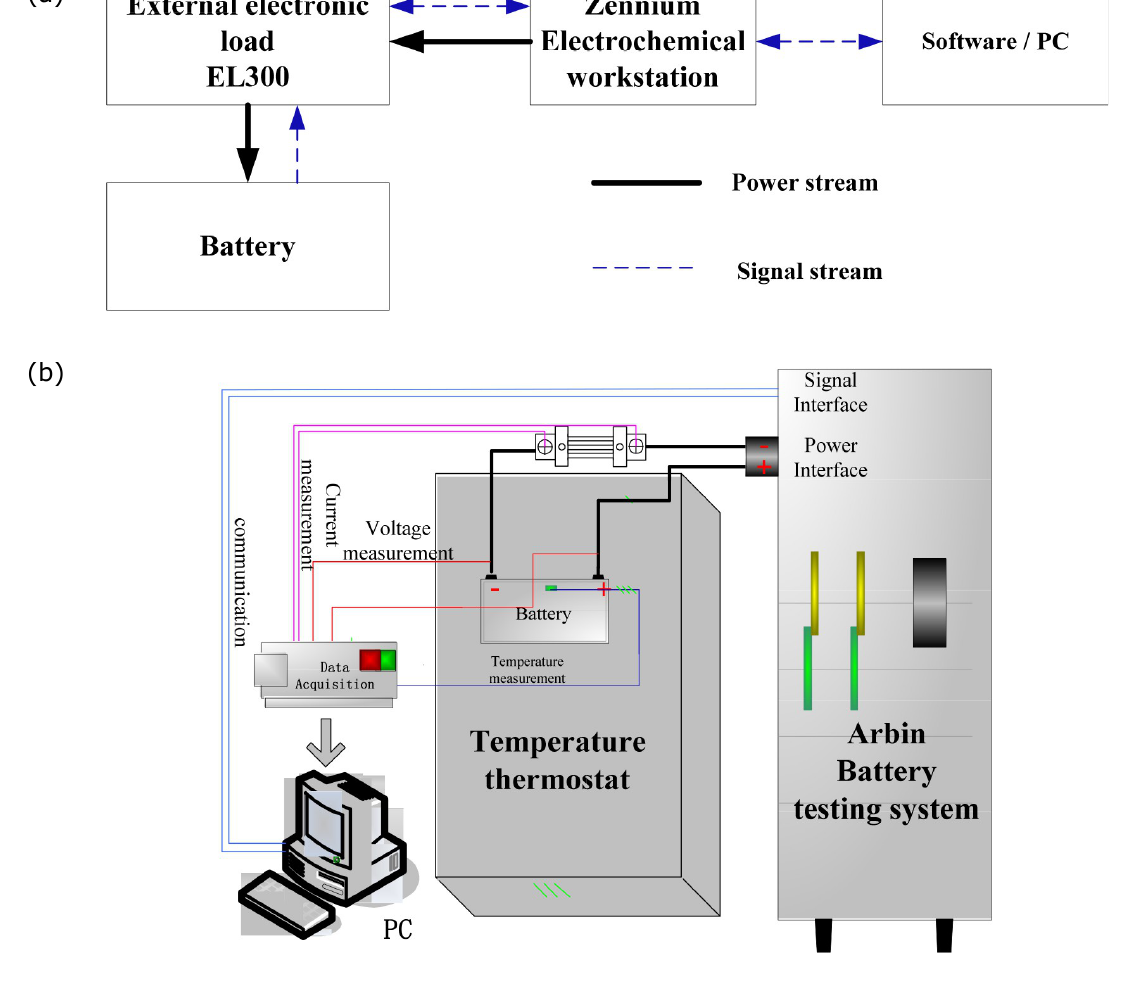
Figure 1. (a) EIS test bench for large lithium-ion cell; (b) Schematic diagram of battery testing